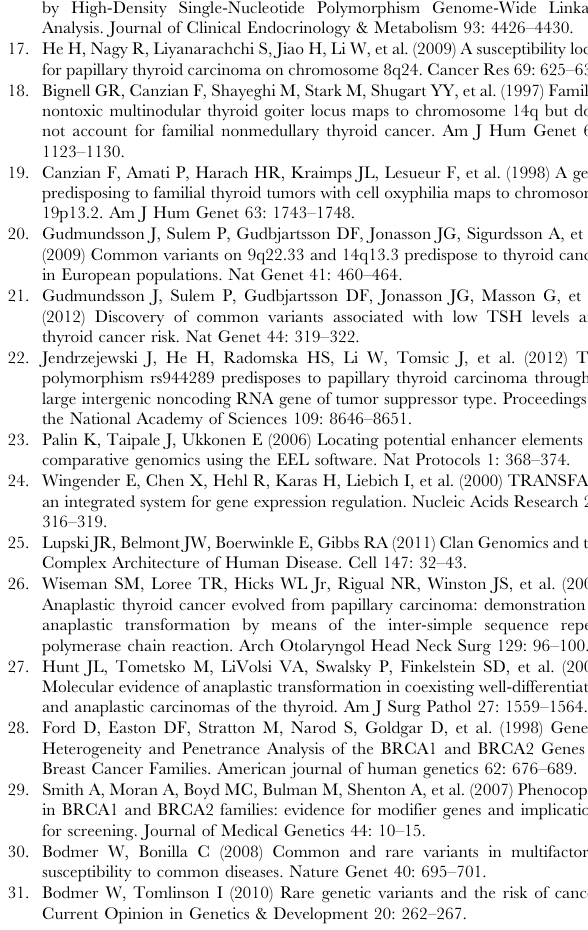
Figure S5 DNA motifs consisting of potential binding sites for transcription factor YY1 and POU2F1. (A) Sequencing chromatogram showing the 4q32A . C mutation with DNA sample of a PTC patient; the DNA motif is boxed. (B) The DNA motifs with the wild type A-allele and mutant C-allele in the 4q32 A . C region. Figure S6 Luciferase assays showing reduced enhancer activity with the mutant C-allele. HeLa cells were transiently co-transfected with reporter constructs containing the wild type A- allele or the mutant C-allele with POU2F1 or YY1 constructs. Data shown are the average of at least three experiments. *, p value , 0.005. Error bars represent 6 SD of at least three independent experiments. Figure S7 4q32 eRNA. (A) The relative position of the eRNA. (B) Detection of 4q32 eRNA in normal thyroid tissues by RT- PCR. M, size marker; ( 2 ), no template; RT ( 2 ), absence; RT ( + ) presence of reverse transcriptase. Total RNA was used for cDNA synthesis; GAPDH was used as an internal control. The primers for the amplicons of the eRNA and GAPDH are provided in Table S2.